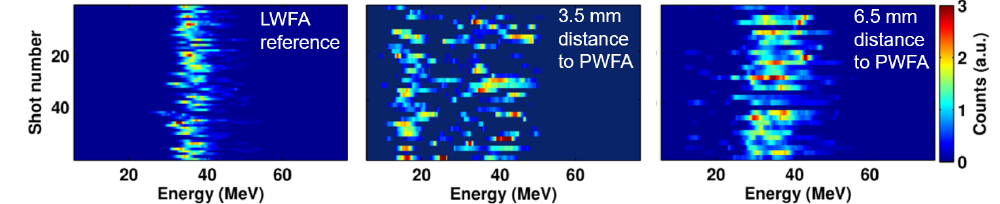
Figure 5. Collective deceleration shown using two separate targets, with varied distance of the PWFA to the LWFA jet (figure adapted from